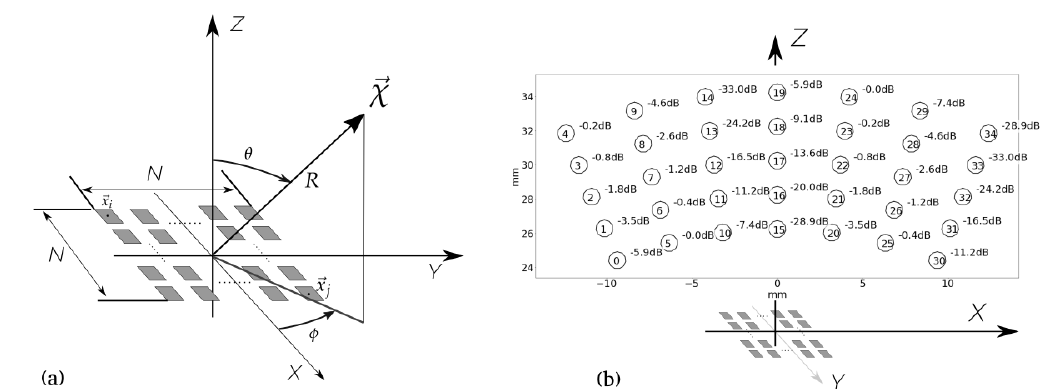
Figure 1. ( a ) Coordinate system used for beampattern simulation; ( b ) test scenario used to evaluate the imaging capabilities of the